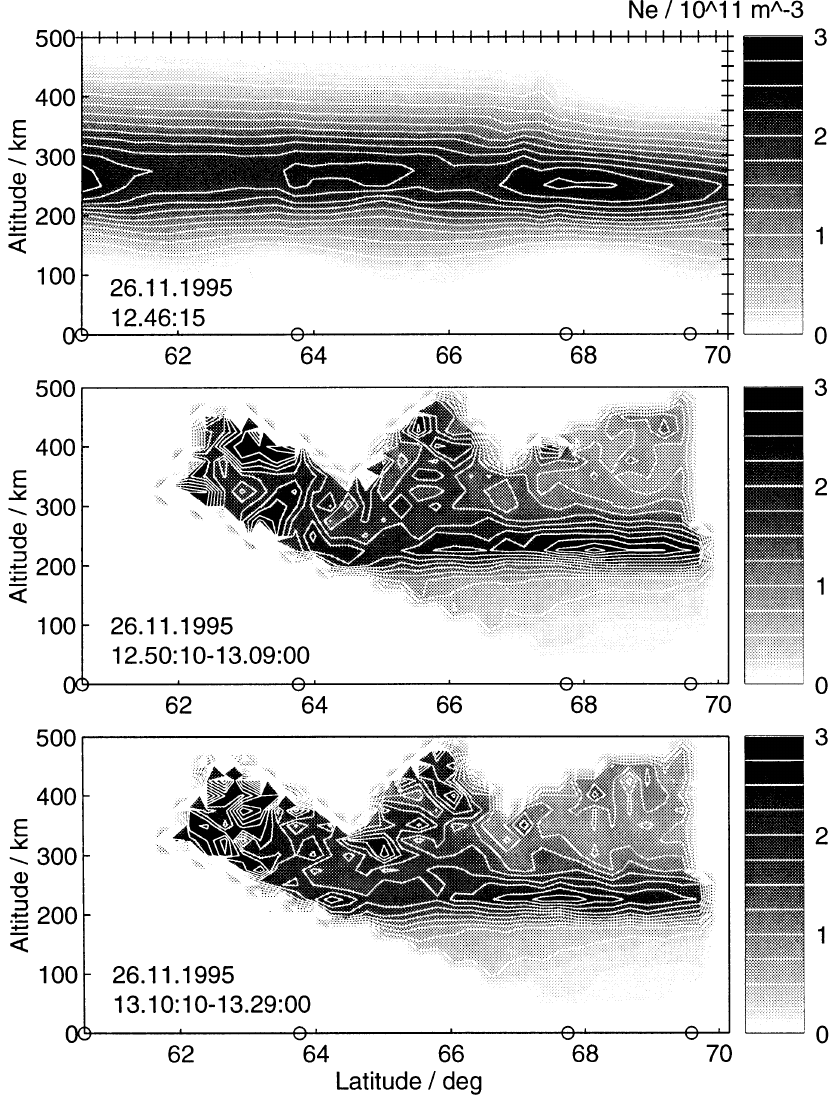
Fig. 1. Comparison of F-region electron densities observed by the tomographic ( top panel ) and incoherent scatter ( centre and bottom panel ) methods. The time in the top panel indicates the start time of the satellite measurement and the time intervals in the other panels the start and stop times of the radar beam scan. The contour interval is 0.25 · 10 (cid:49)(cid:49) m (cid:126)(cid:51) . The open dots on the horizontal axis show the satellite receiver sites and the tick marks on the top and right-hand side of the top panel indicate the grid used in the tomographic analysis. The radar electron densities are averages within the same